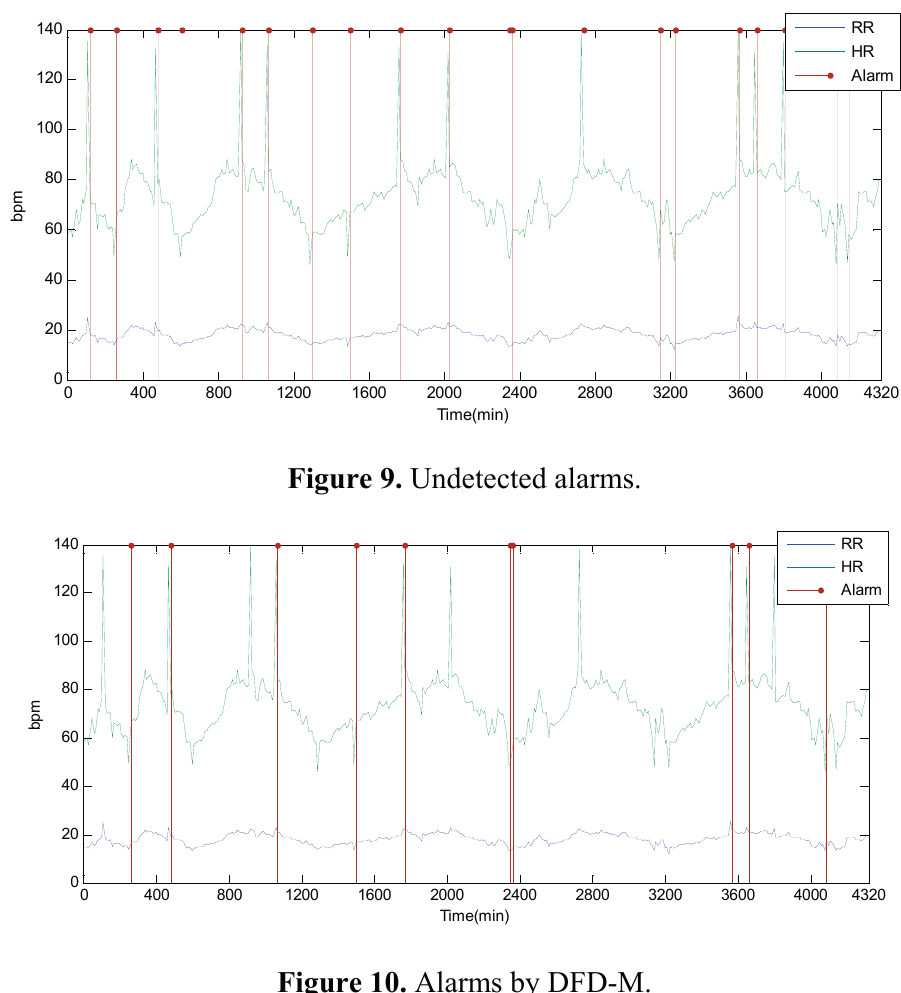
Figure 10. Alarms by